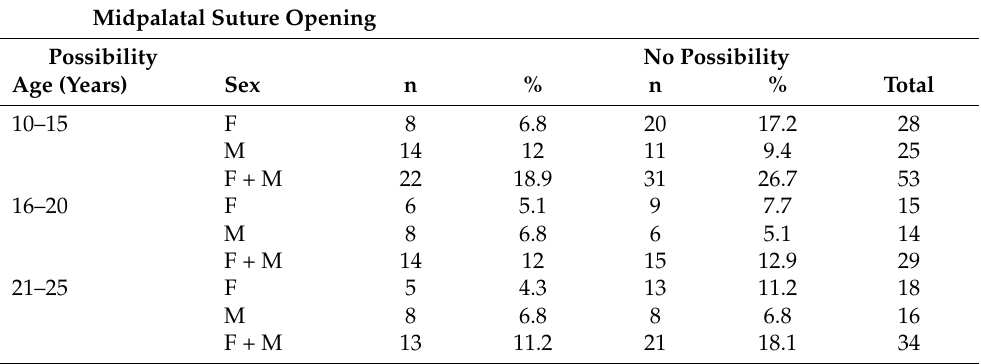
Table 5. Distribution of MPS maturational stages by age group and sex regarding the possibility of finding midpalatal suture opening.